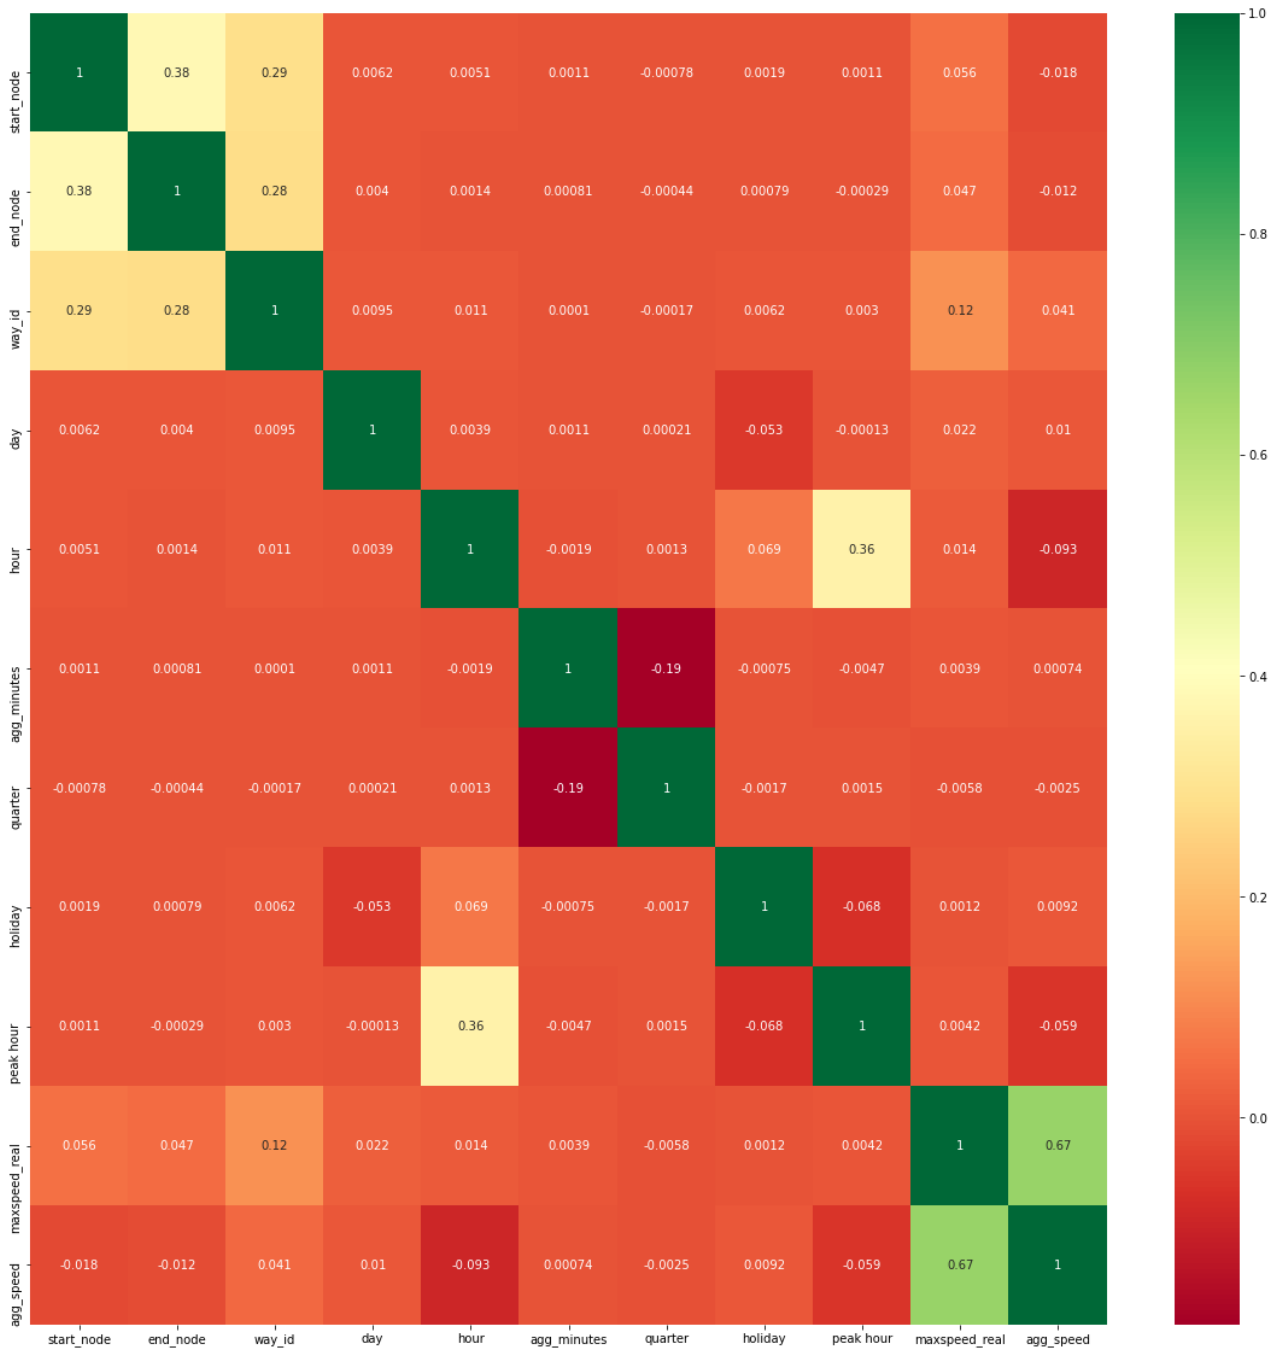
Figure 5. Heat map of hybrid feature